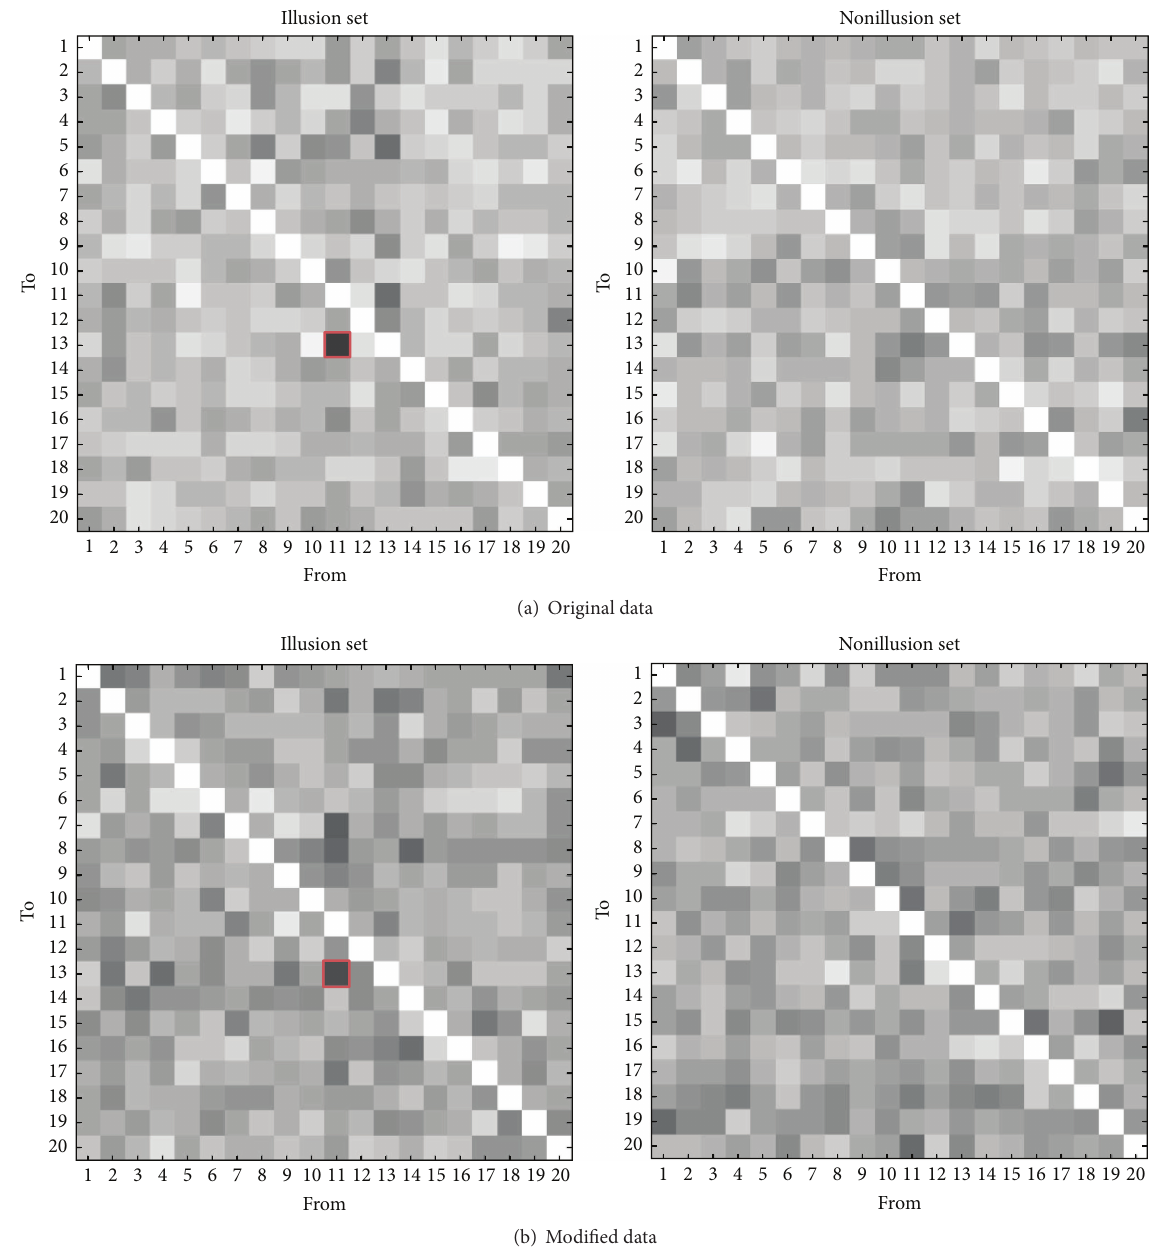
Figure 5: Average functional connectivity matrix. Each square represents the rate of connectivity based on oxy-Hb. The thicker color of square, the more connectivity was found. (a) The matrices got by analyzing original data. The rate of connectivity from ch. 11 (right frontal cortex) to ch. 13 (right motor related areas) in illusion set (left matrix, red square) was 73.3%, which was the most among all connectivity and significantly more than that in nonillusion set. (b) The matrices got by modified data. The rate of connectivity from ch. 11 to ch. 13 in illusion set (left matrix, red square) was 66.7%. The rate was also the most among all connectivity, although it was not significantly but slightly more than that in nonillusion